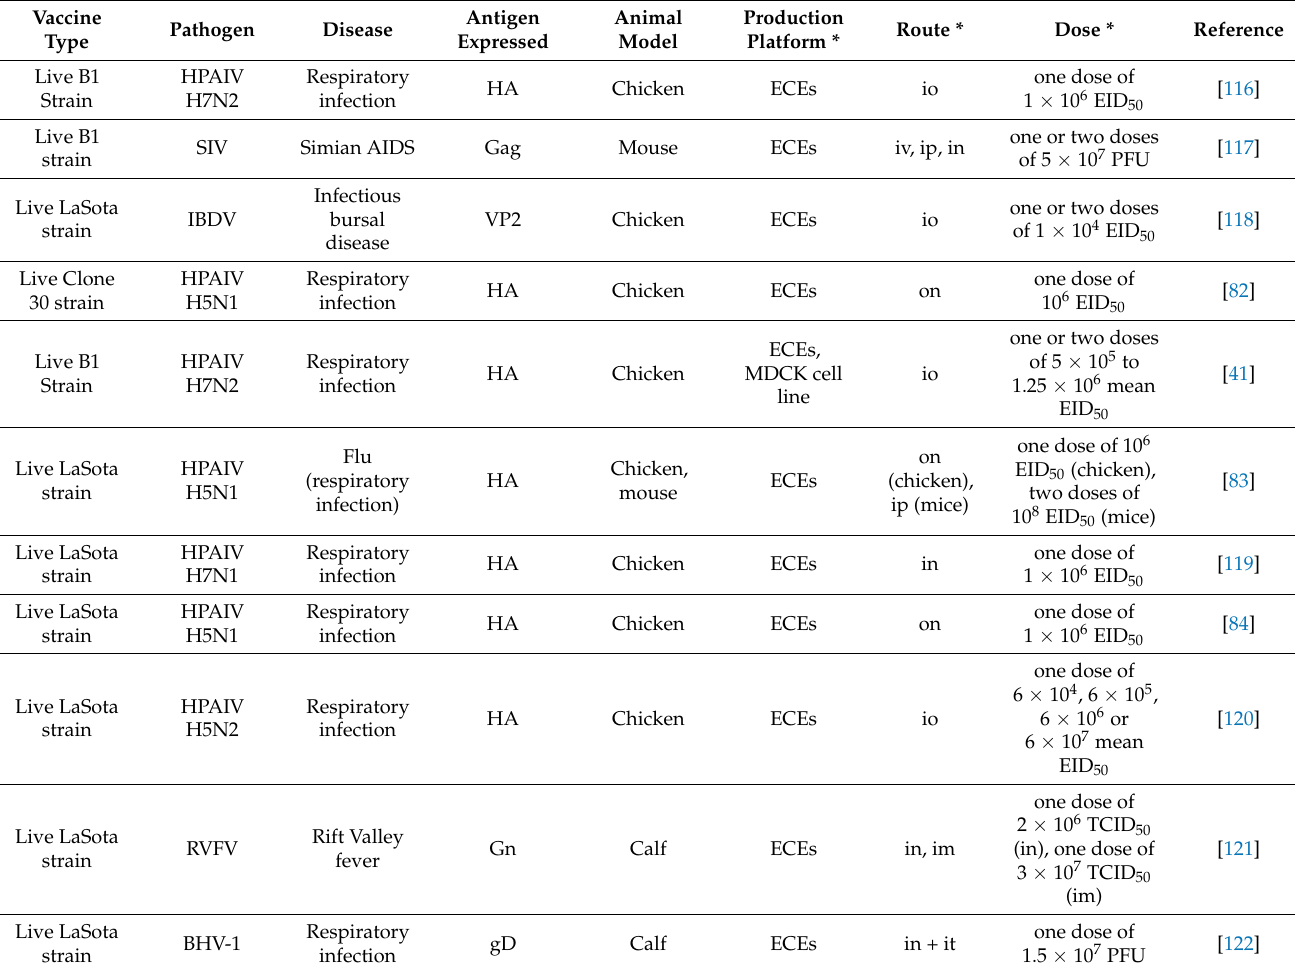
NDV-vectored vaccine candidates for veterinary use in chronological